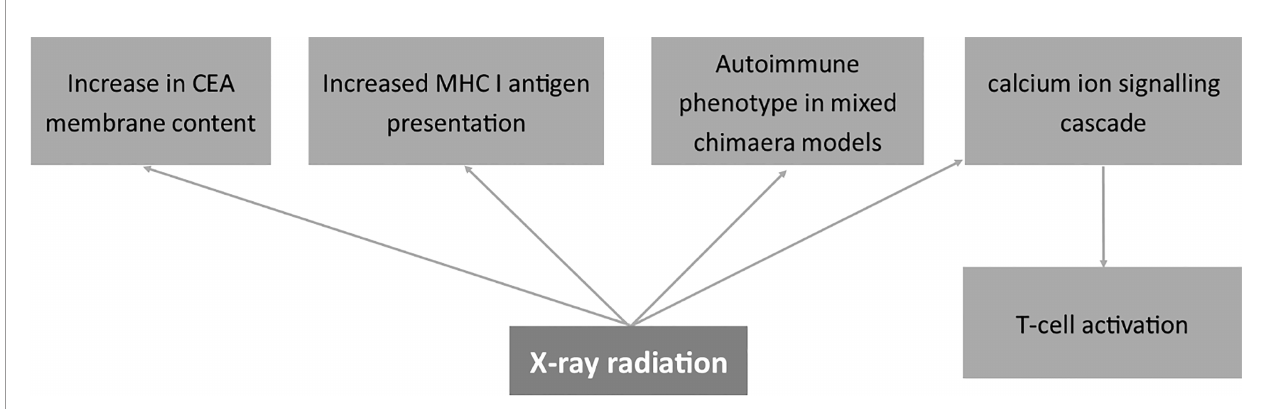
FIGURE 6 | Effects of X-ray radiation on the expression of membrane antigens. Carcinoembryonic antigen (CEA), Major Histocompatibility Complex I (MHC